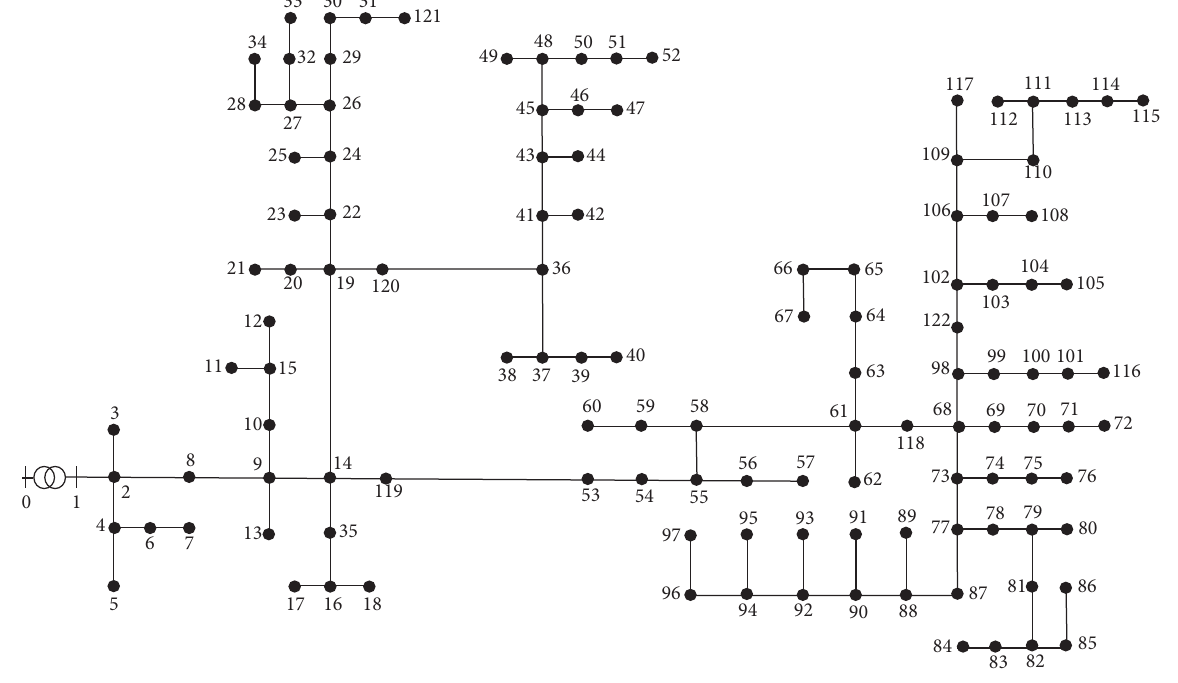
Figure 3: 123-bus network. Table 2: Line impedance of 19-bus